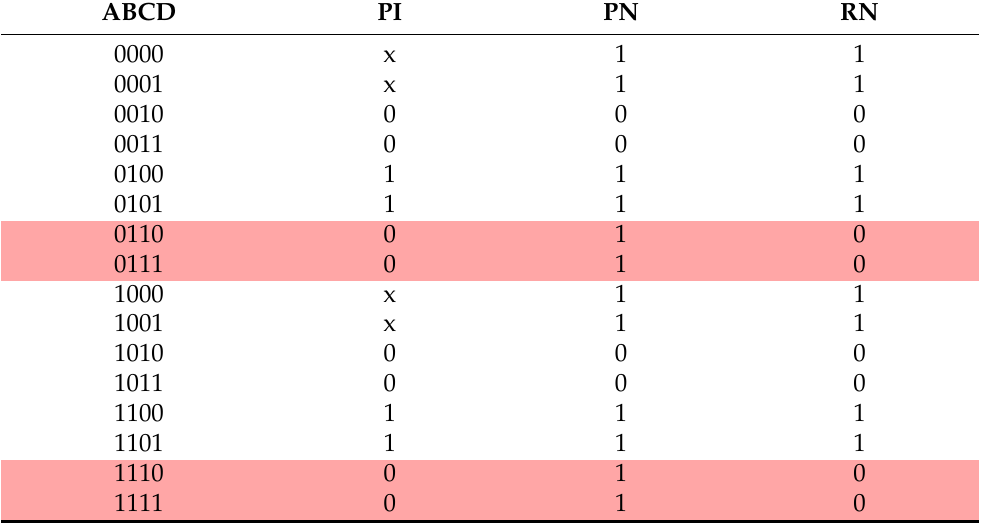
Table 3. Truth tables for the node D. It is conveyed the information stored in the Pathway Infor- mation (PI), Prenetwork (PN), and Resulting Network (RN). The red rows indicate the arguments combinations to which the value in the pathways information is not the same to the one expressed in the prenetwork. The x represents undefined values that, consequently, cannot be imposed over the